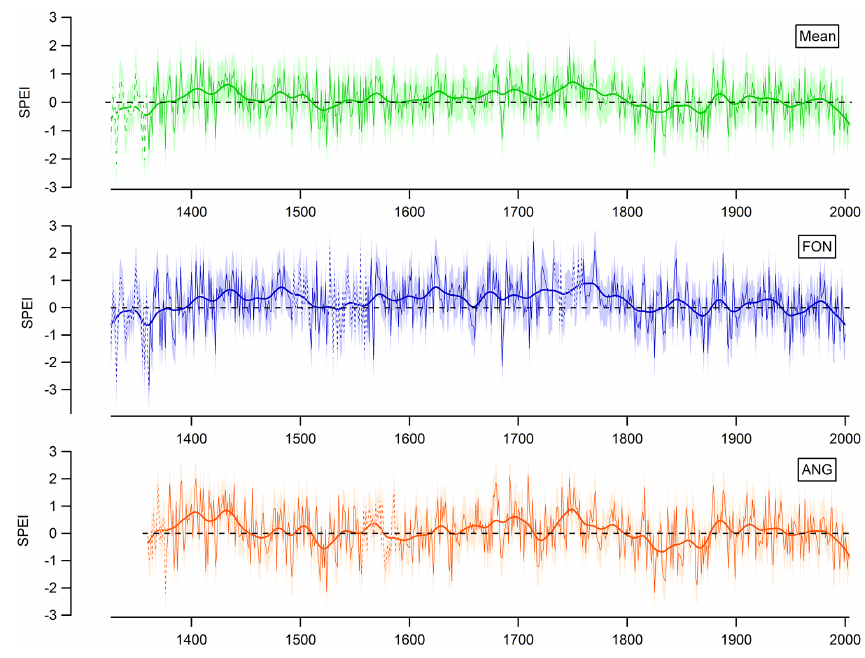
Figure 10. Reconstructions of the drought index SPEI (June–August) based on tree ring cellulose δ 18 O for Fontainebleau (FON), Angoulême (ANG), and a composite reconstruction for the two sites (mean). The thick lines are the fitted 30-year cubic smoothing splines. The shaded areas mark the confidence intervals of the reconstructions, and the dotted lines mark the parts of the chronologies where the number of trees is <